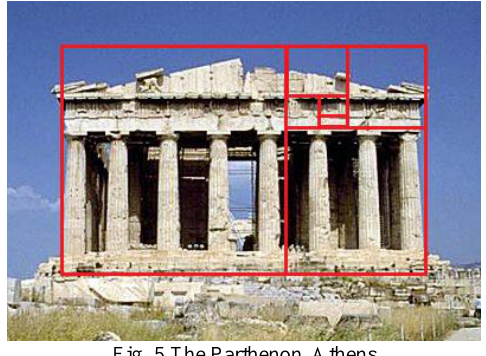
Fig. 5 The Parthenon, Athens